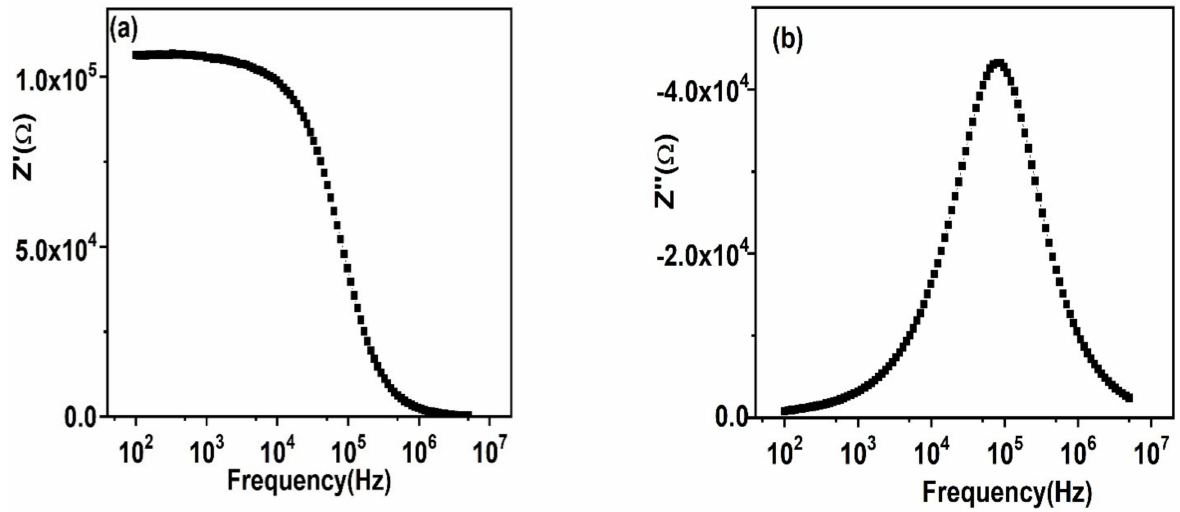
Figure 10. Frequency relying on the performance of ( a ) Z (cid:48) ; ( b ) Z (cid:48)(cid:48) of impedance formalism.